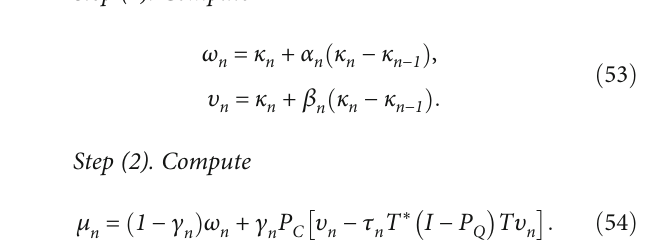
Figure 3: Numerical computational behavior of Algorithm 1:, Algorithm 2:, Algorithm (4.2) while κ 0 = κ 1 = 3 e 2 t t 4